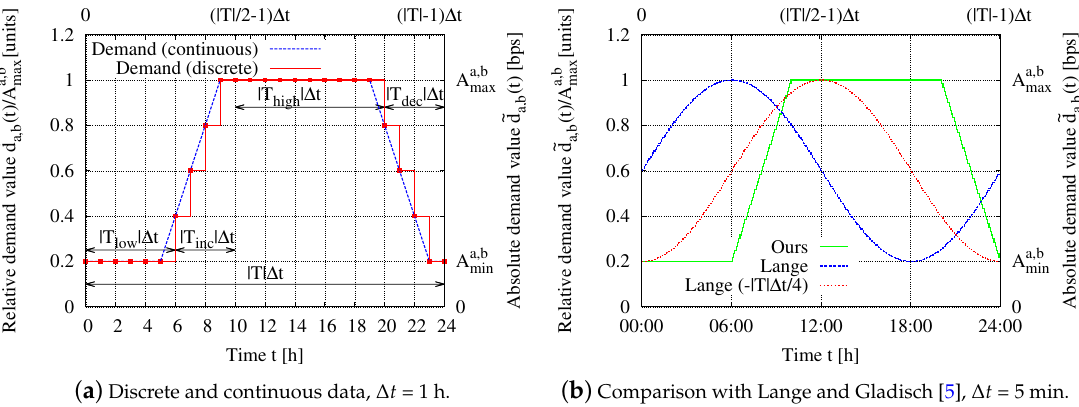
Figure 1. Temporal traffic model with exemplary relative demand values and even number of elements in the set of time periods T covering a